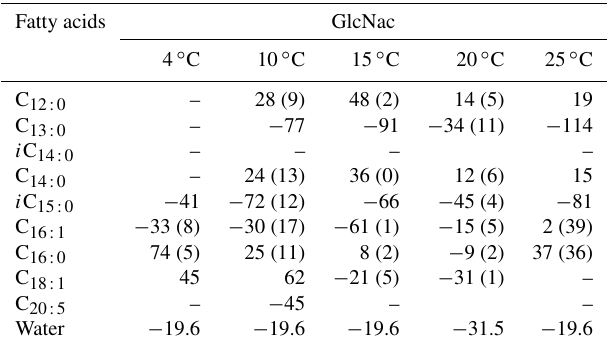
Table 2. The hydrogen isotopic values of fatty acids in S. piezotol- erans WP3 growing at different temperatures using GlcNac as the sole carbon source. For better comparison, none of the cultures have been shaken; “–” indicates that the concentrations are too low for δ 2 H measurements. Standard deviations of two duplicate cultures are given in